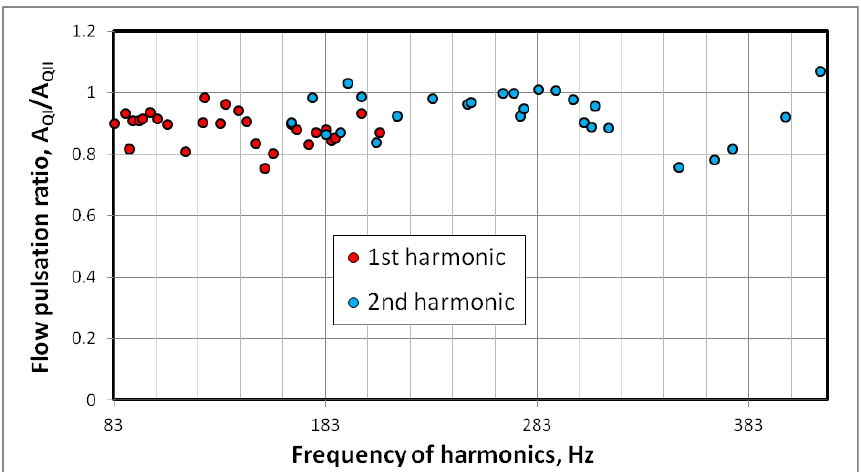
Figure 28. The ratio of the flow pulsation amplitudes determined using the “infinitely long” and “short” pipelines.